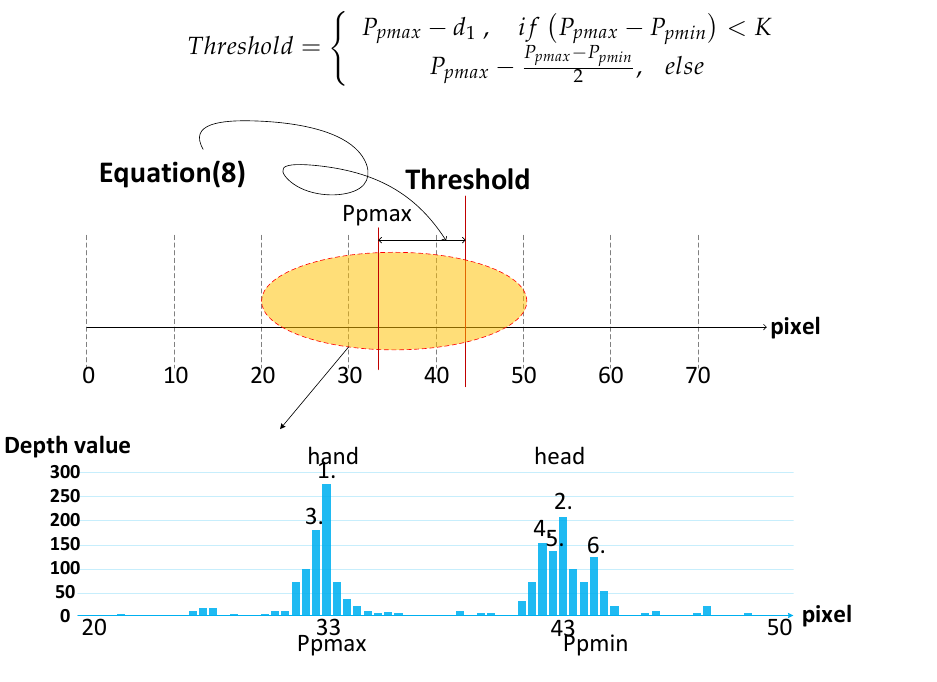
Figure 6. The schematic diagram of adaptive dynamic threshold.